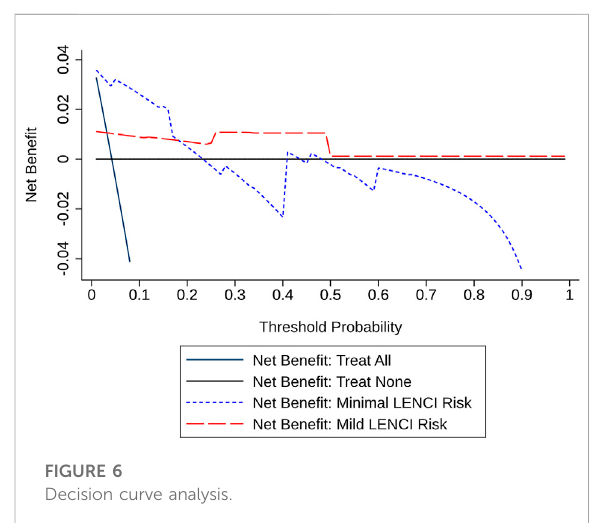
FIGURE 6 Decision curve